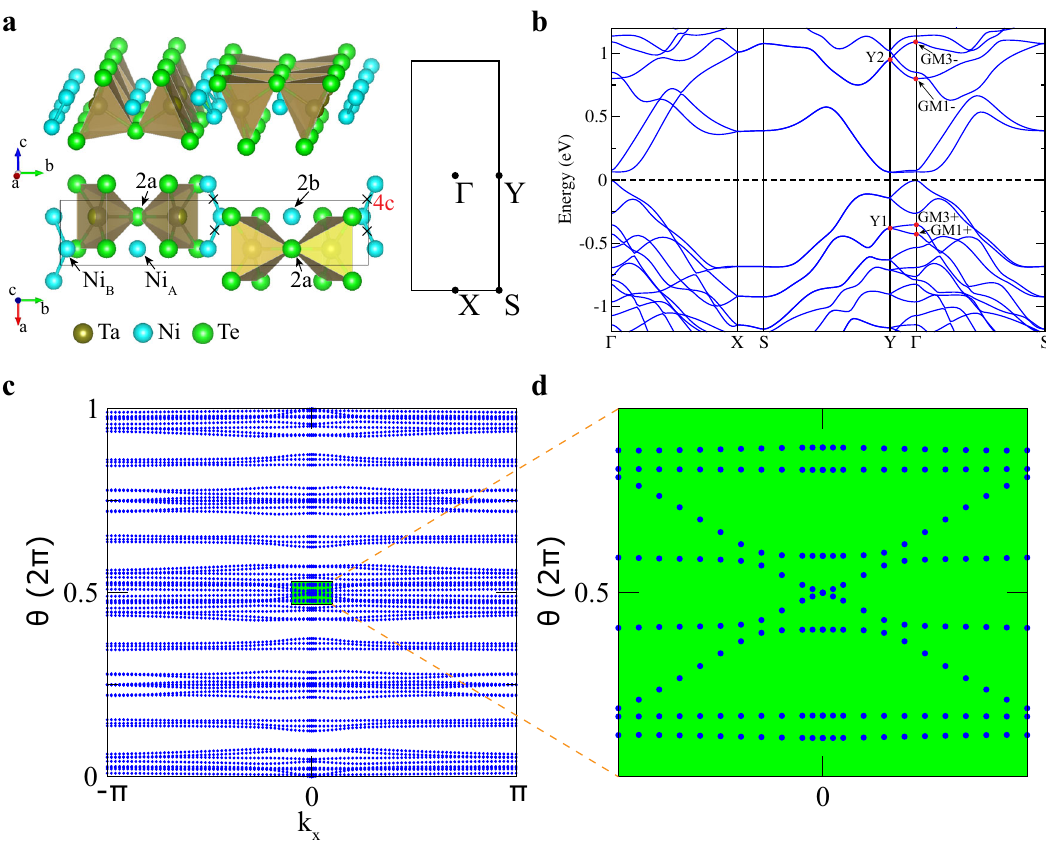
Fig. 1 Crystal structures and electronic structures of Ta 2 Ni 3 Te 5 monolayer. a The crystal structure, Wyckoff positions and Brillouin zone (BZ) of Ta 2 Ni 3 Te 5 monolayer. b Band structure and irreps at Y and Γ of Ta 2 Ni 3 Te 5 monolayer. c The 1D k y -direct Wilson bands as a function of k x calculated in the DFT code. d Close-up of the green region in ( c ), with one crossing of Wilson bands at θ = π indicating the second SW class w 2 =